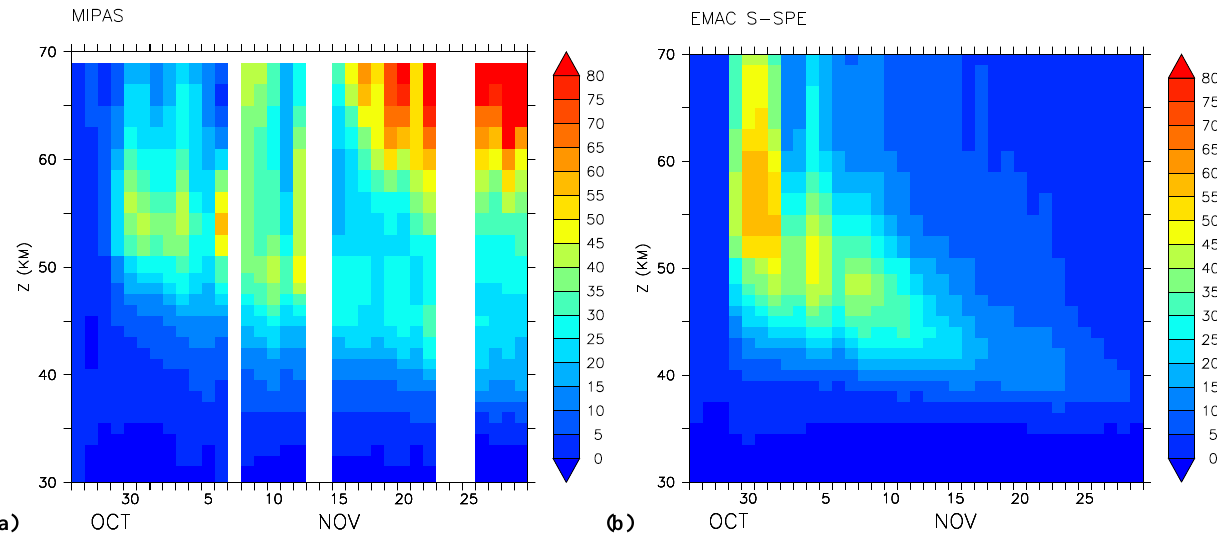
Fig. 4. NO 2 change (ppbv) with respect to 26 October for 70–90 ◦ N for (a) MIPAS, (b) EMAC simulation S-SPE.